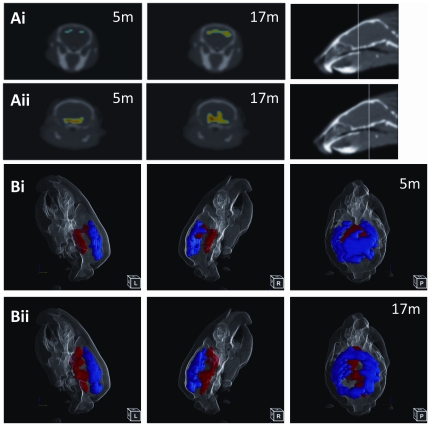
Brain metabolism: FDG PET/CT phenotype of PLB1 mice.In vivo FDG-PET images and surface renderings of PLB1Triple vs. PLB1WT animals at 5 and 17 months are depicted. Graded 2D coronal sections (A) show the expanding regions of decreased (Ai) or increased metabolism (Aii) (relative to whole brain activity), the location of the cross sections is indicated on the right. The full extent of metabolic group differences is illustrated at 5 (Bi) and 17 months (Bii) for lateral (L:left; R:right) and dorsal (P:posterior) views of 3D surface rendered images; areas of significant metabolic increase (red) and decrease (blue) are based on SPM at P<0.01, the reliability of clusters was also confirmed (family-wise errors, P<0.05). A surface render of a CT image provides the anatomical reference.